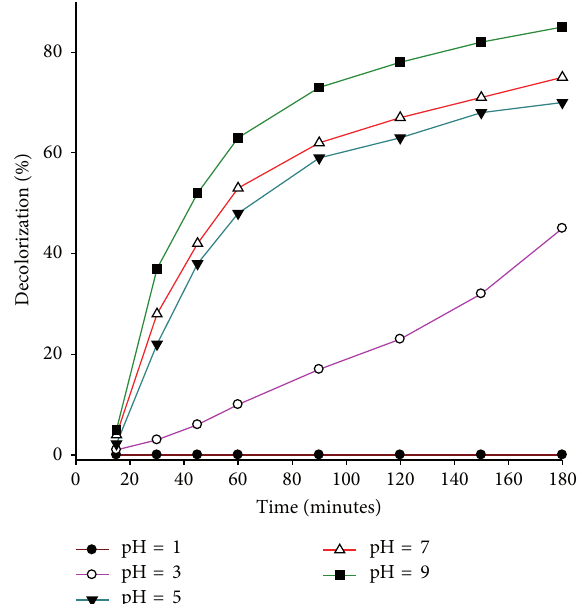
F 7: Effect of solution pH on the MG dye decolorization; of the catalyst; initial dye concentration, 20ppm; 55WHg 0.6gL lamp; continuous stirring; irradiation time, 180min; room temper- −1